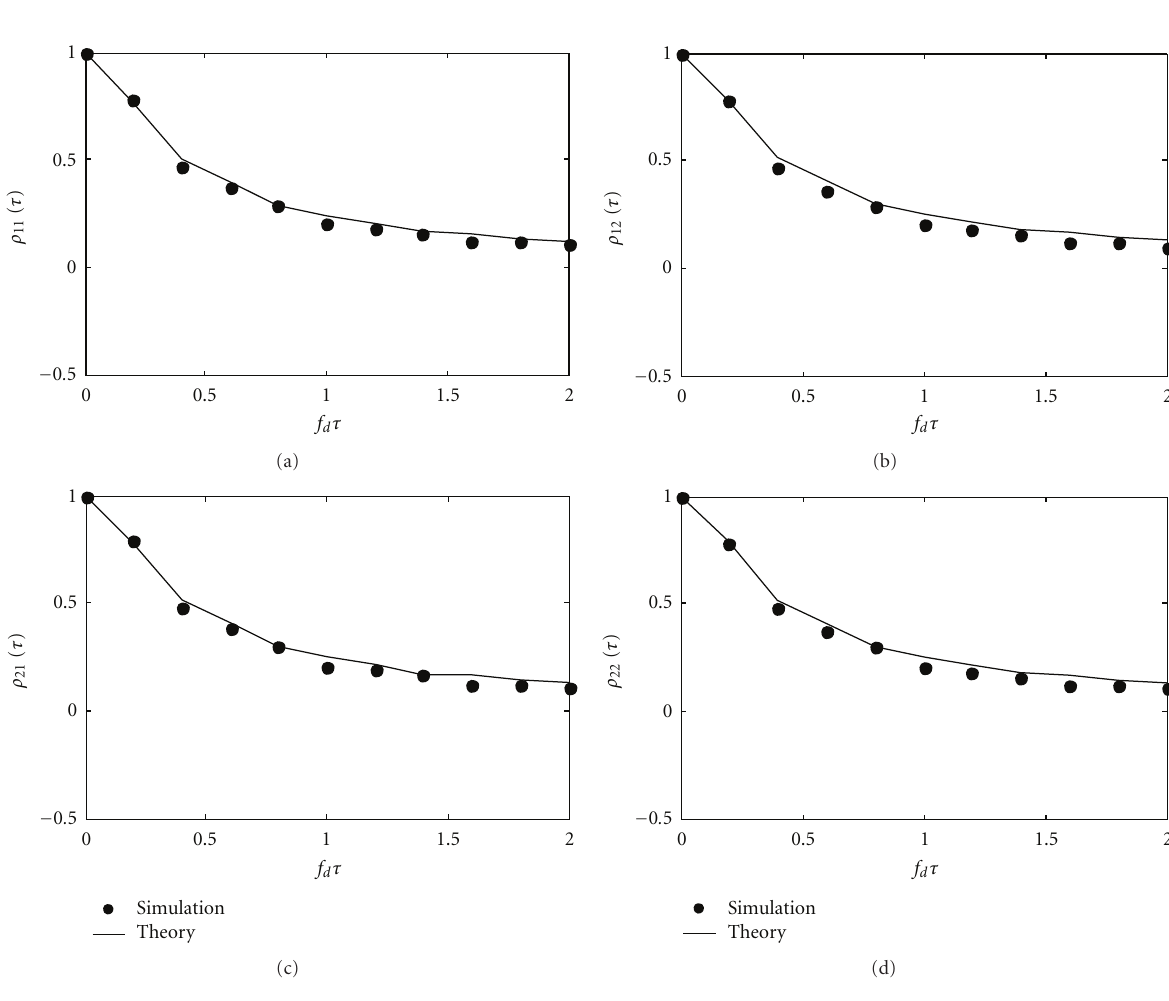
Figure 8: The TCCs of simulated subchannel fading